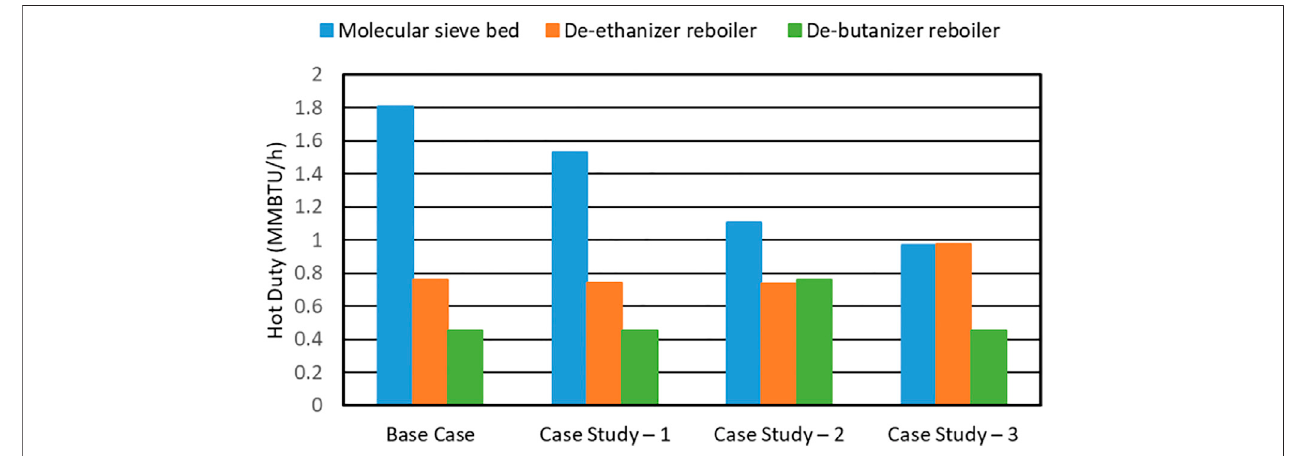
FIGURE 8 | Hot utility duties for the molecular sieve bed, de-ethanizer, and de-butanizer reboilers for the base case and different case studies.